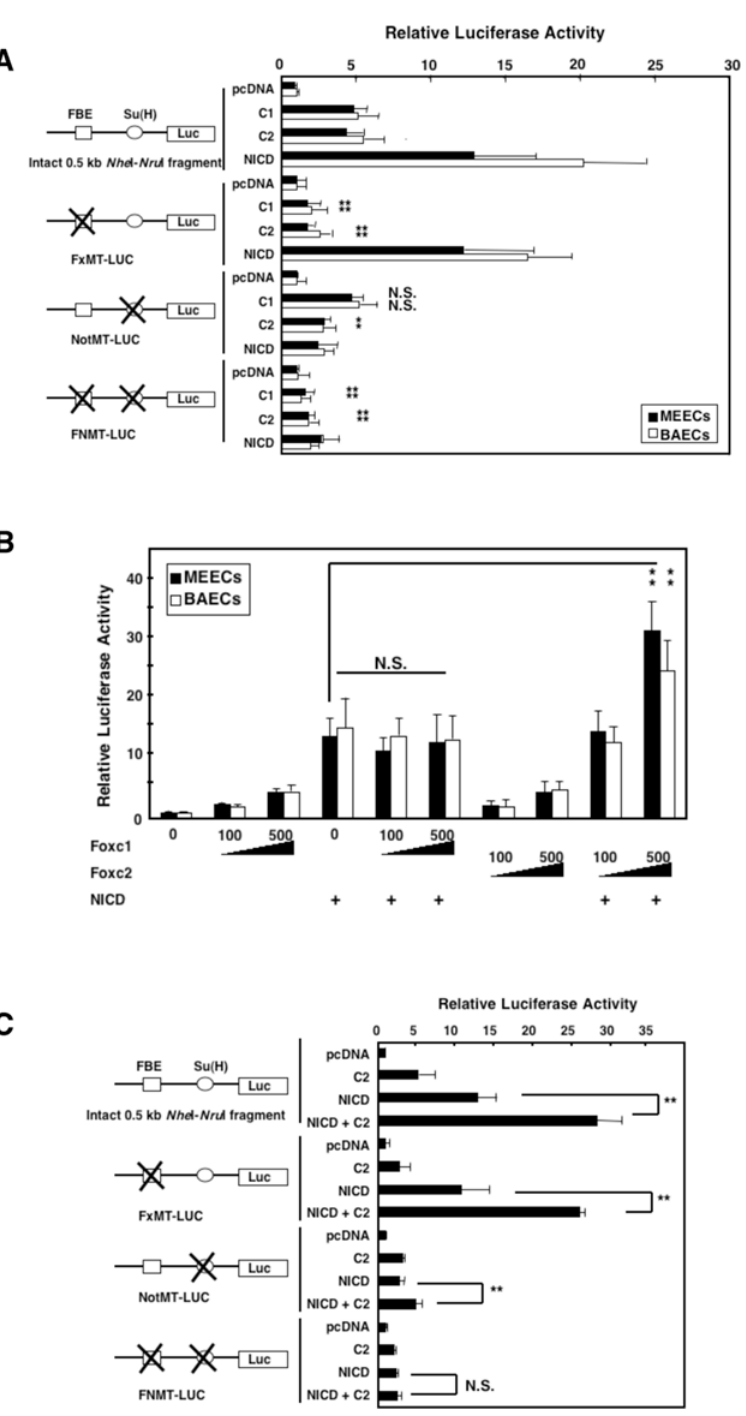
Figure 2. Foxc2 and NICD synergistically activate the Hey2 promoter. (A–C) Luciferase assays. Values are means + s.d. of 3 experiments in triplicates. Statistical significance was determined by Student’s t -tests. (A) Foxc-mediated promoter activity was analyzed by Hey2 luciferase constructs containing mutations in the FBEs, the proximal Su(H) sites, or both. *p , 0.05, **p , 0.01 versus the intact promoter with either Foxc1 or Foxc2. N.S., non-significant. (B) Synergistic activation of the Hey2 promoter by combinations of Foxc2 and NICD. **p , 0.01 versus NICD. N.S., non- significant. (C) Foxc2 and NICD synergistically induce Hey2 expression largely via the Su(H) site and partially via the FBE. **p , 0.01 versus NICD. N.S., non-significant. doi:10.1371/journal.pone.0002401.g002 not Foxc1, directly bound to GST-Su(H) (Figure 3B). Interestingly, results obtained from the luciferase reporter assays (Figure 2), these when Foxc2, NICD and Su(H) were incubated together, the three findings suggest that Foxc2 is directly involved in the NICD-Su(H)- proteins formed a protein complex (Figure 3B). Coupled with the mediated transcriptional activation of Hey2.